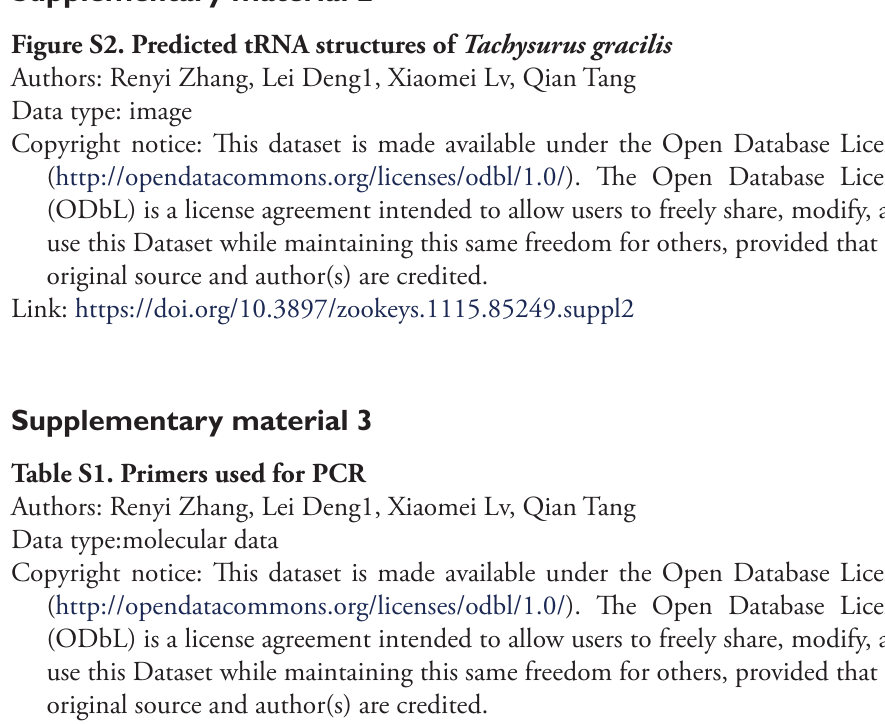
Figure S2. Predicted tRNA structures of Tachysurus gracilis